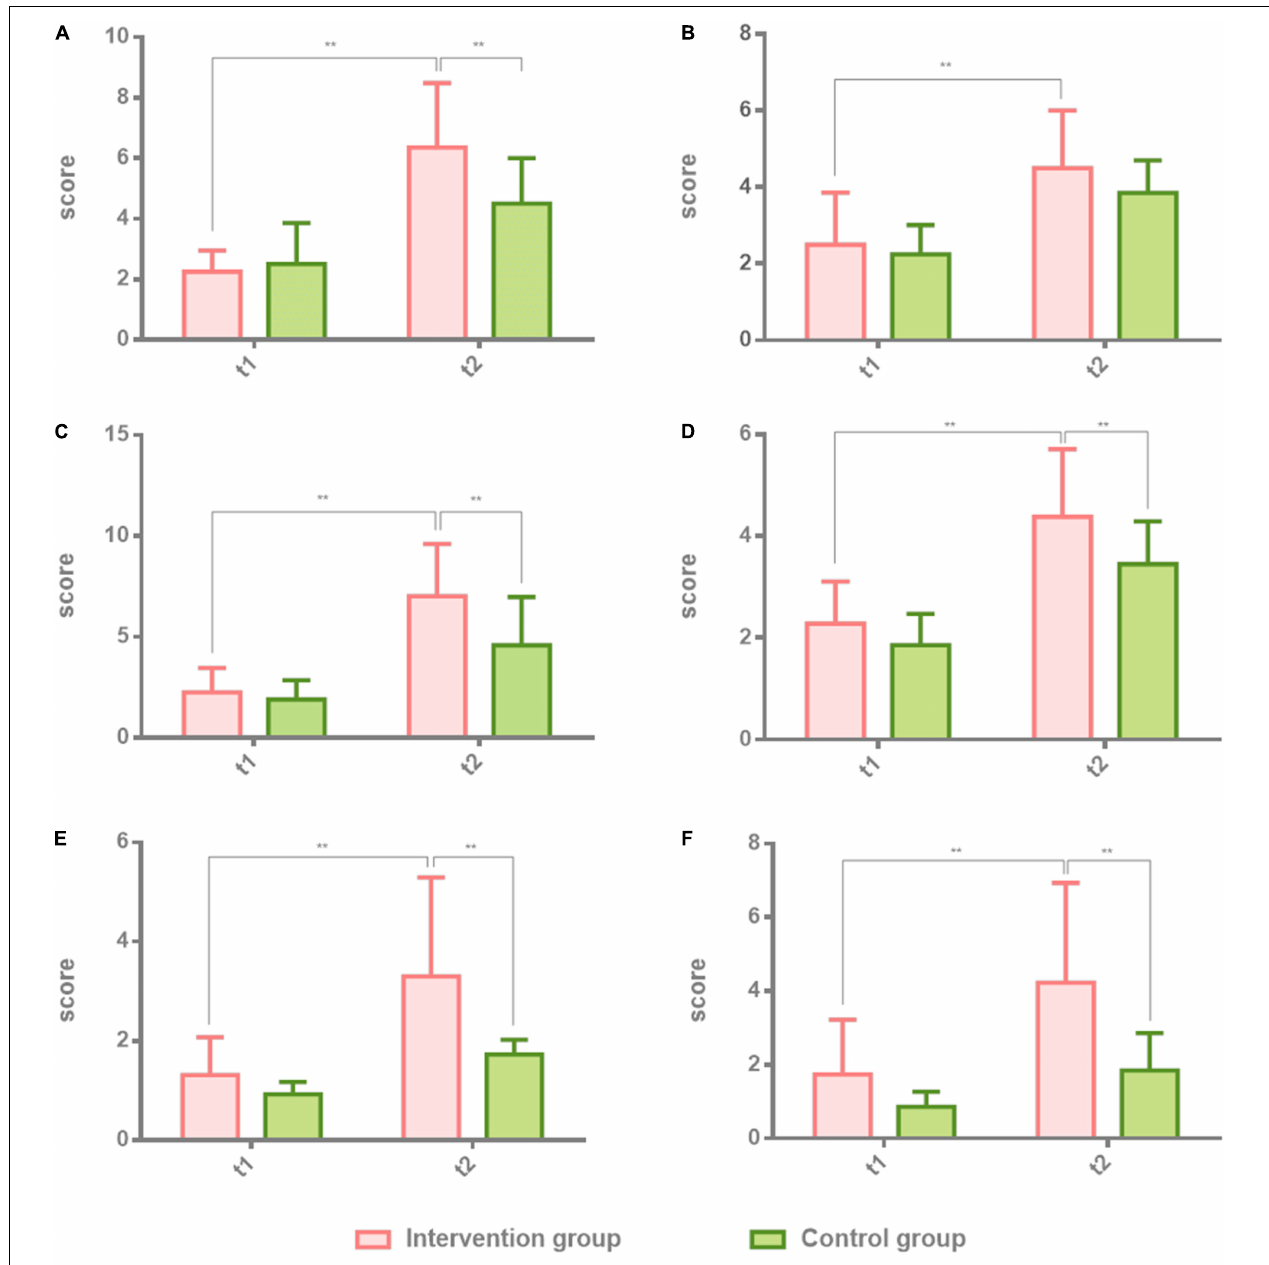
FIGURE 2 | Comparison of spontaneous speech, repetition, and listening comprehension in patients with non-fluent aphasia with the intervention group and the control group. The intervention group: melodic intonation therapy group; the control group: speech therapy group. (A–F) Information, fluency, repetition, true or false, word recognition, and sequential commands. Data are expressed as mean ± SD ( n = 20) and analyzed by repeated-measures analysis of variance. * p < 0.05, ** p < 0.01. t 1 , baseline; t 2 , after 8